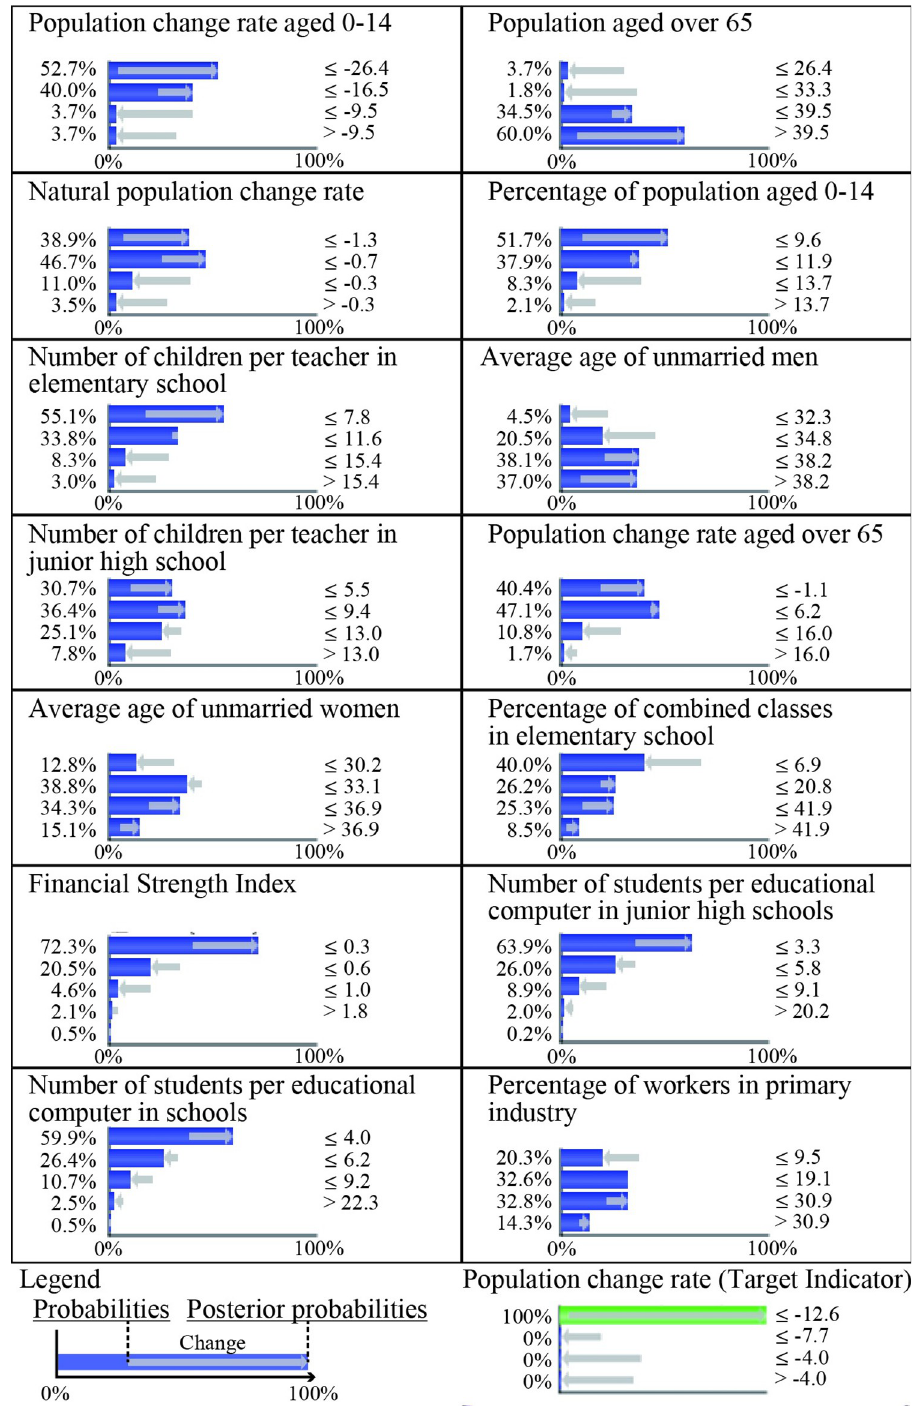
Fig 3. Probabilistic change of shrinking cities with rapid population decline. Fig 3 focuses on 14 indicators with STE more than |0.2|.